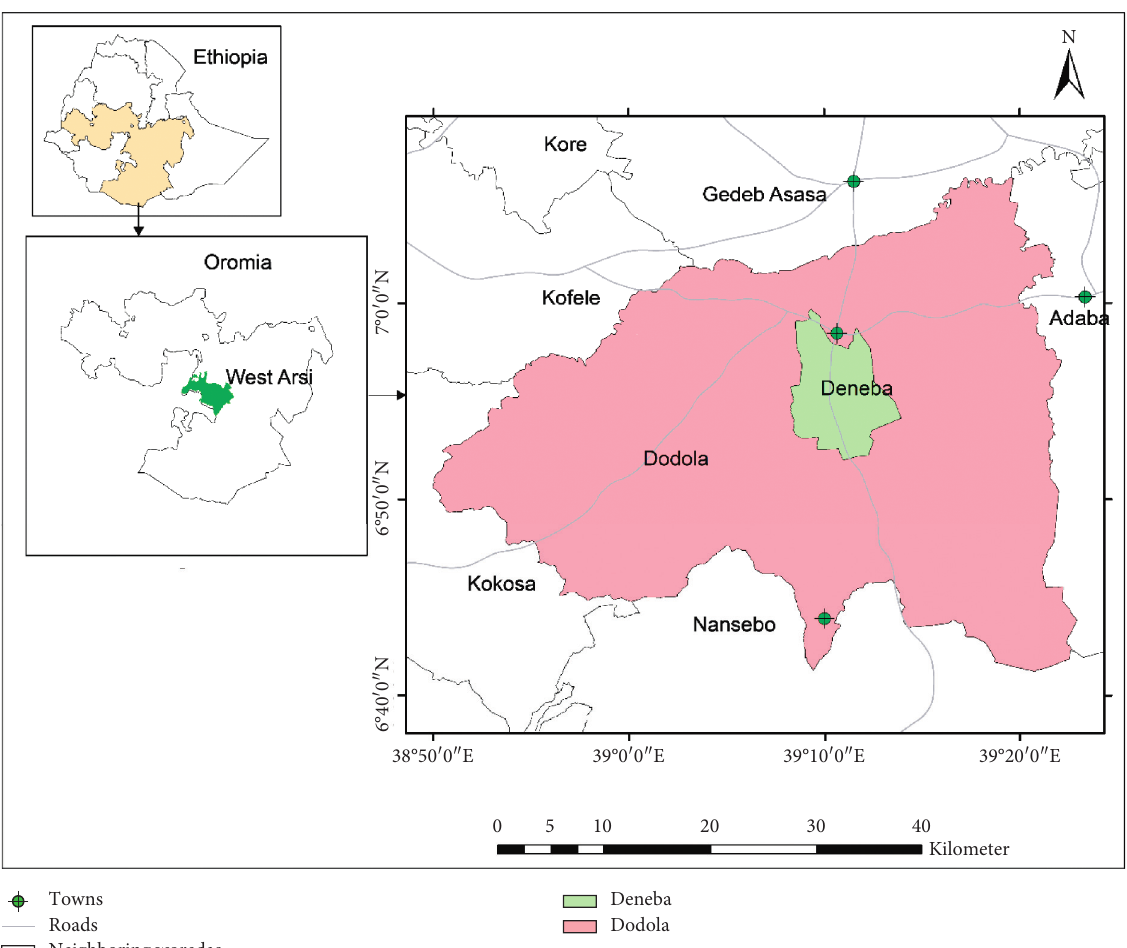
Figure 1: Location map of the study area (Gole forest),